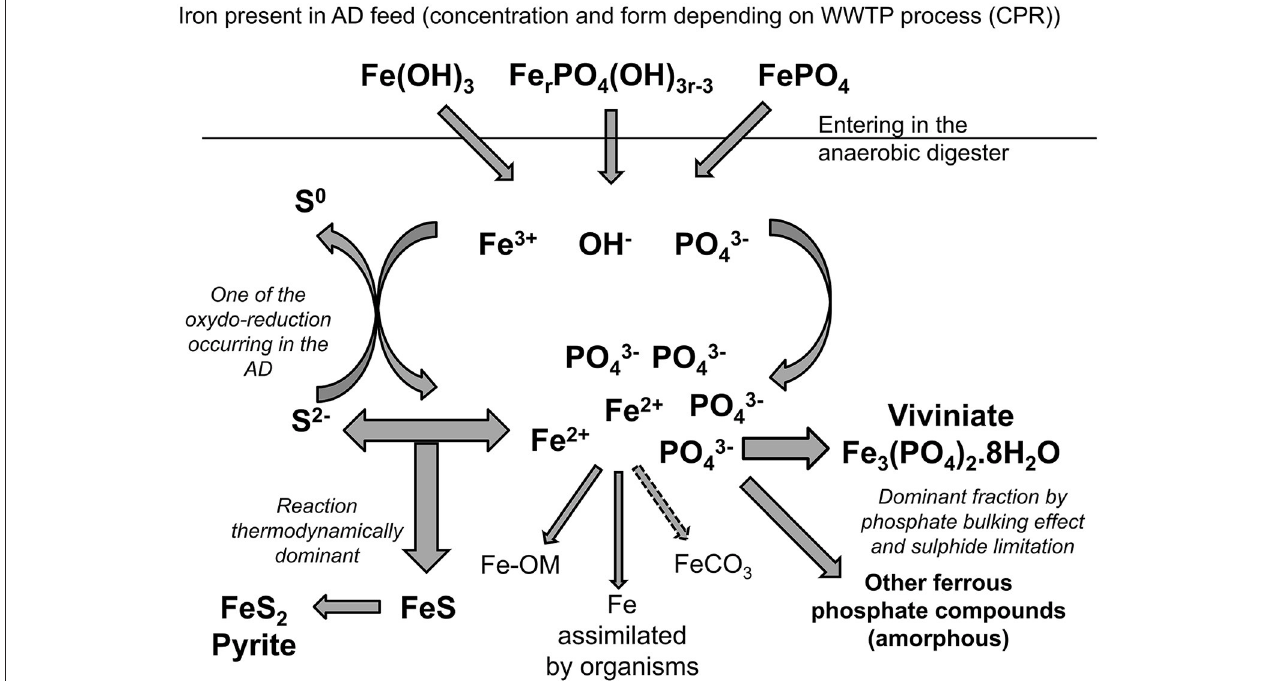
FIGURE 7 | Illustration of iron behavior in anaerobically digested